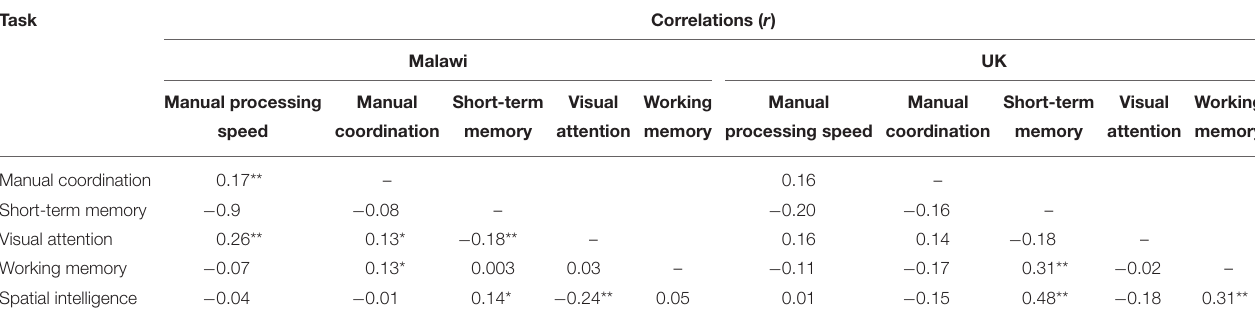
TABLE 3 | Convergent construct validity: correlation matrix across all six tasks for Malawi and UK